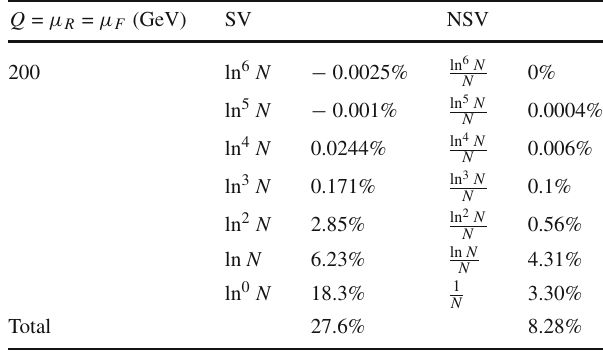
Table 4 % contribution of SV distributions and NSV logarithms to the Born cross section at N 3 LO for Q = 200